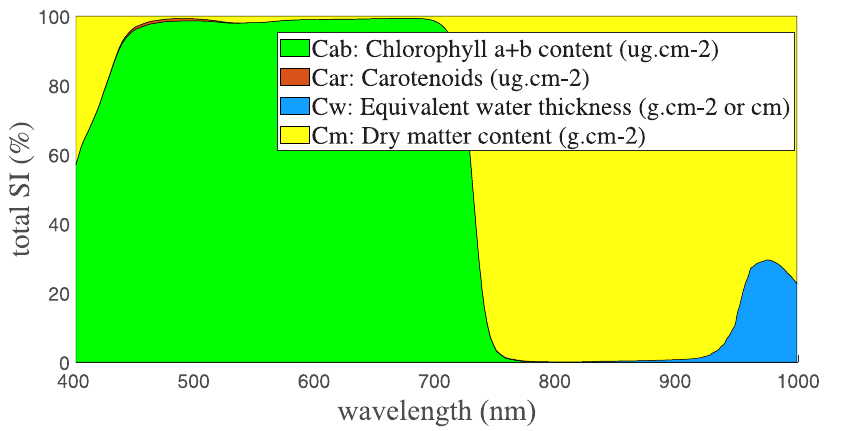
Fig 3. Global sensitivity analysis of the input parameters in the PROSPECT